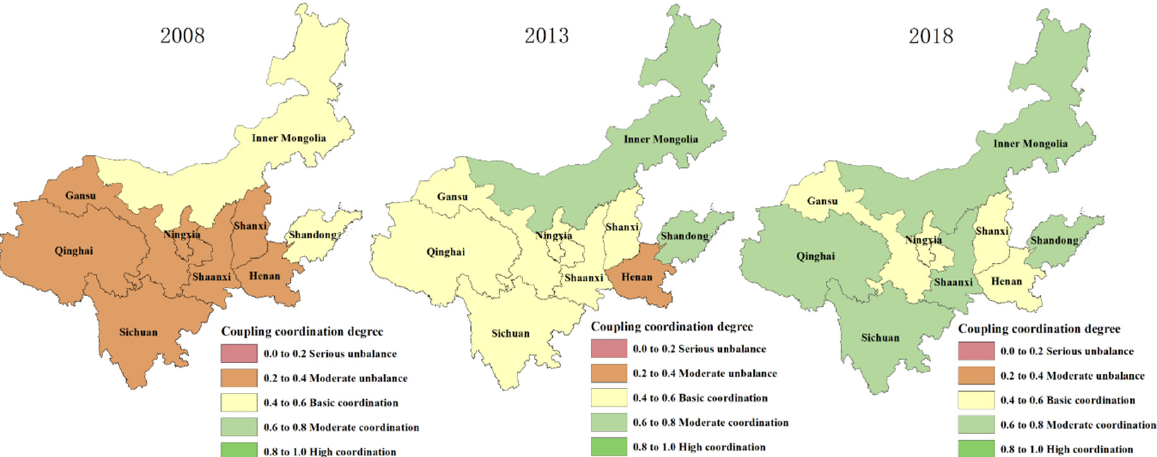
Figure 5. Spatial differentiation of the level of coordination of “production-living-ecological” spatial function coupling in the Yellow River Basin.